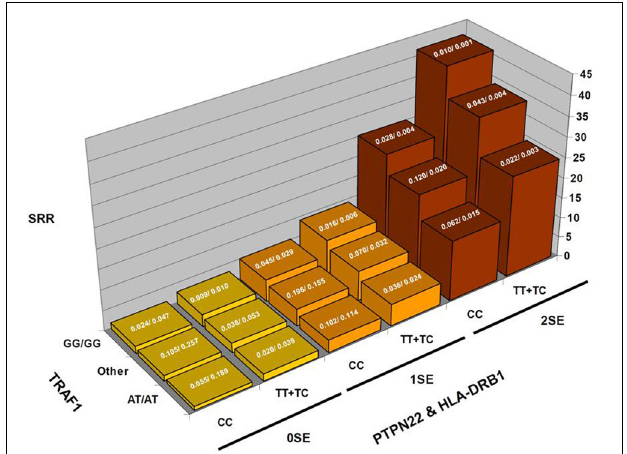
FIGURE 1 | Rheumatoid arthritis scaled posterior probabilities (SRR). Genotype data at three strongly predisposing loci, HLA-DRB1 , TRAF1 , and PTPN22 are combined and the posterior probabilities calculated for every possible multilocus genotype combination. The prior probability was set to the approximate population prevalence of rheumatoid arthritis, 0.01. The posterior probabilities are scaled such that the lowest RA-risk multilocus genotype was set to a value of 1. The results show a 41-fold variation in posterior probabilities. The expected frequencies of the various multilocus genotype combinations in RA patients/controls are shown at the top of each